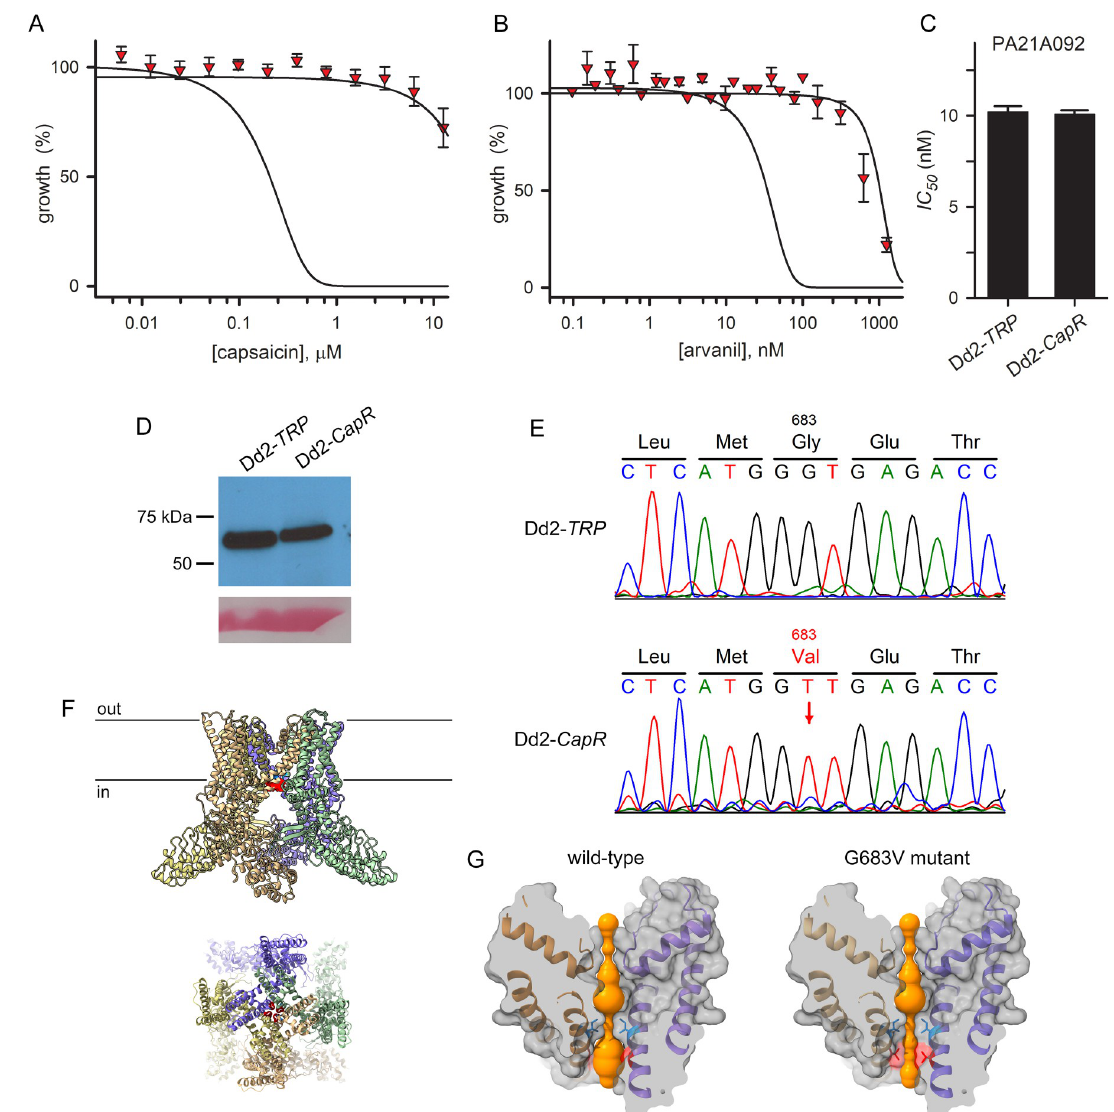
Fig 5. Rapid selection of a mutant that avoids cation leak at the PPM. (A, B) Mean ± S.E.M. growth of Dd2- CapR at indicated [capsaicin] and [arvanil] (red triangles), determined by combining results from 3 independent trials each. In each panel, black lines represent best fits for dose-response data in matched experiments using wild-type Dd2 and Dd2- TRP (top and bottom) to single sigmoidal decay. Note that Dd2- CapR sensitivity to both ligands is indistinguishable from that of the wild-type parent, indicating a quantitatively complete loss of efficacy against the engineered transfectant. (C) Mean ± S.E.M. half-maximal growth inhibition concentrations ( IC 50 ) for indicated parasite lines by the PfATP4 inhibitor PA21A092. Selection did not alter the parasite’s susceptibility to PfATP4 block. (D) Anti-HA immunoblot showing TRPV1 expression in Dd2- CapR . Bottom, Ponceau S loading control. (E) Sequence chromatograms from the Dd2- TRP transfectant and the selected Dd2- CapR clone, showing the single nucleotide polymorphism that alters G683 (rat TRPV1 numbering) to valine. (F) Modeled cartoon structure of rat TRPV1 with the G683V mutation, based on the cryo-EM structure [15]. This mutation (red) is at the lower TRPV1 gate and lines the ion conduction pore; side and top views of the membrane-embedded channel are shown (top and bottom images). (G) Cutaway side views of wild-type and mutant channel pores. Blue sticks represent the sidechain of I679, which forms the lower gate in the wild-type channel [43]; the position of G683 and the larger valine sidechain in the mutant are shown in red cartoons, sidechain sticks, and associated surface patches. The solvent-accessible pathway was mapped using the HOLE program and its surface is shown in orange. Note the narrowed pore in the mutant (bottom), suggesting that cation flux is prevented by an occluded pore.